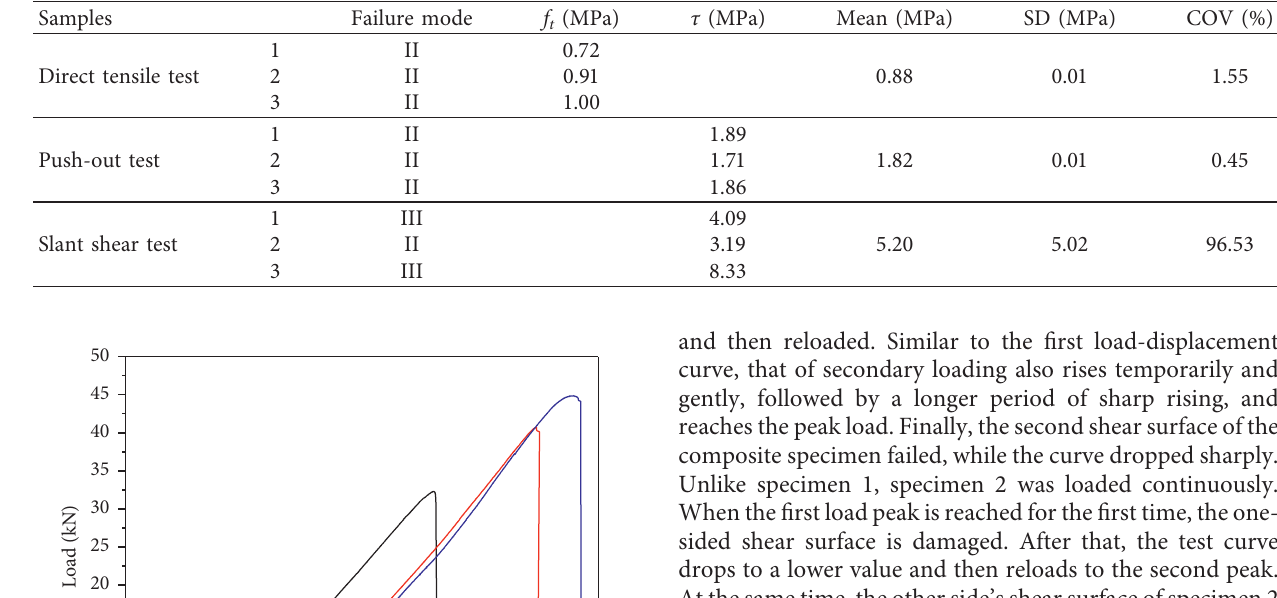
Table 5: Experimental results in the direct tensile, push-out, and slant shear tests.